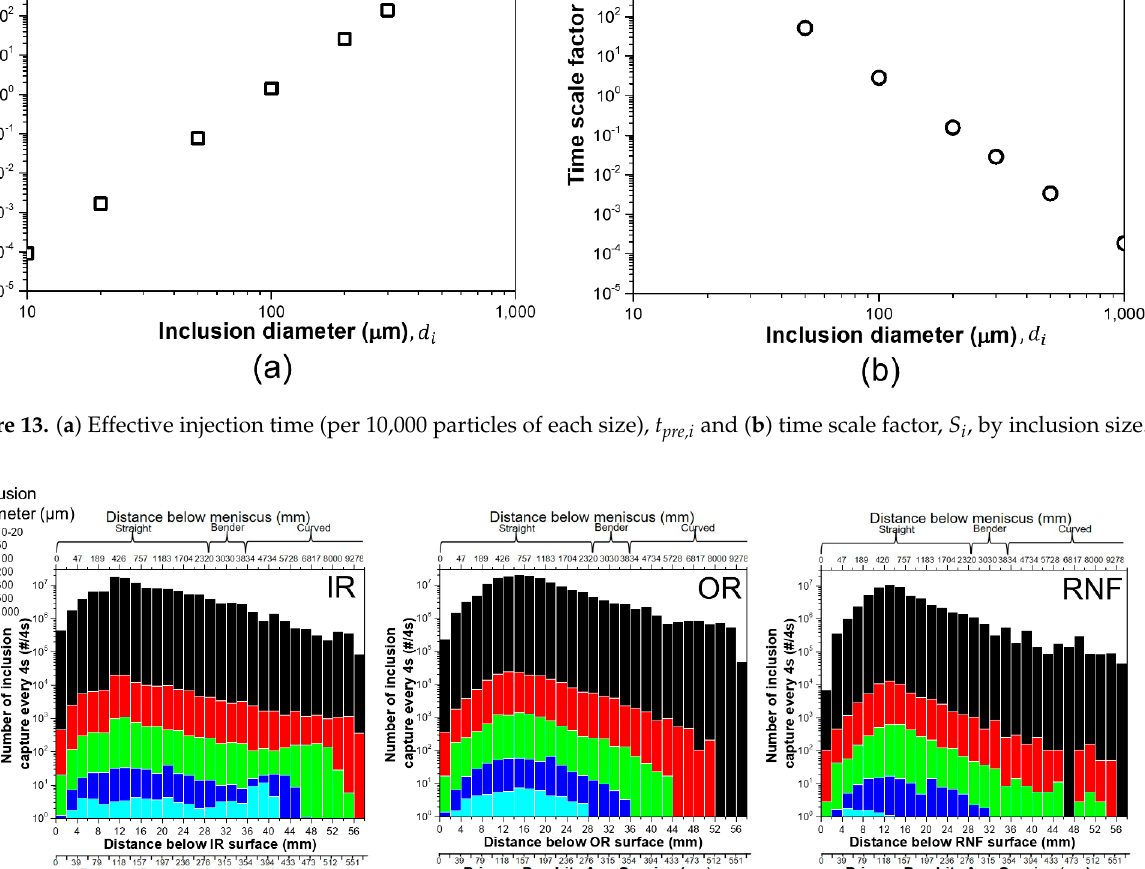
Figure 14. Histograms of the predicted inclusion capture rate in the steel sample, by locations and sizes of the captured inclusions: ( a ) the IR shell, ( b ) the OR shell, and ( c ) the right NF shell.